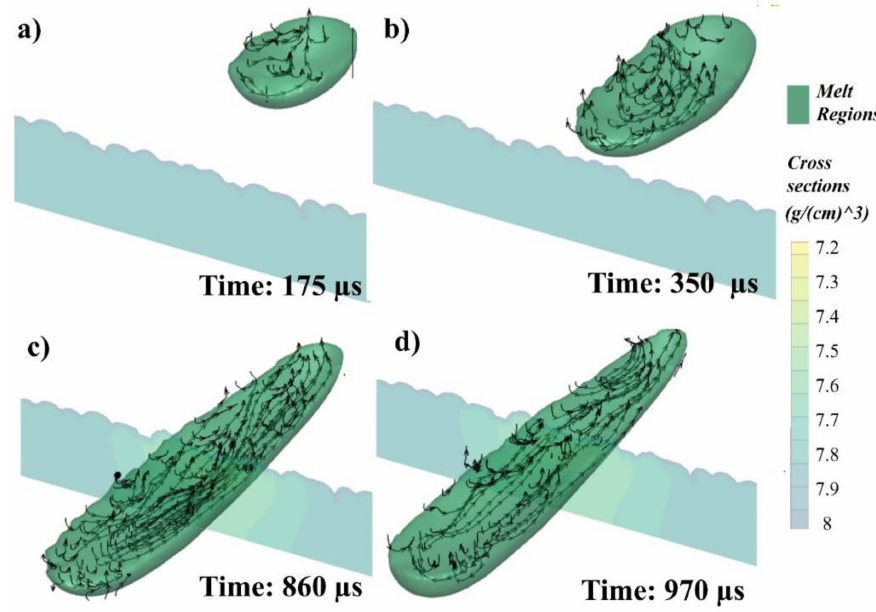
Figure 13. Flow passing through cross-section at ( a ) 175, ( b ) 350, ( c ) 860, and ( d ) 970 µ